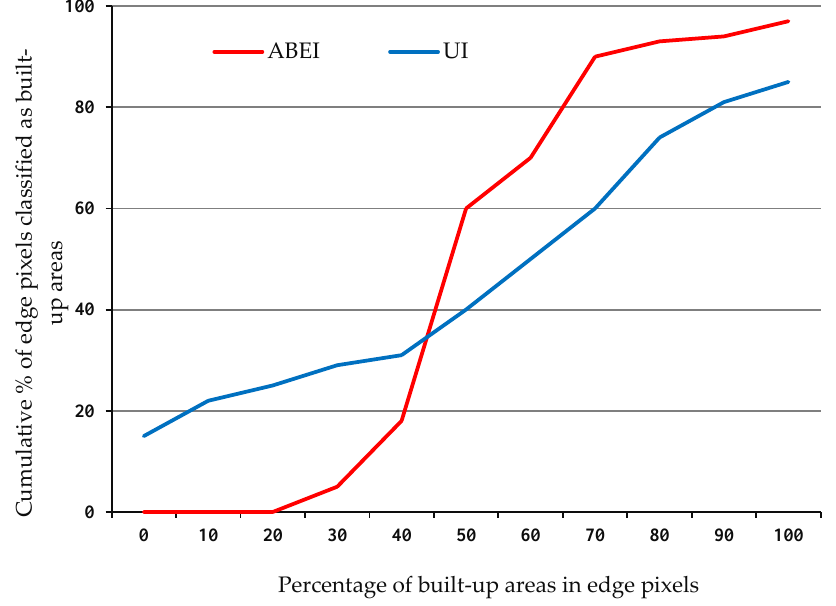
Figure 4. Cumulative frequency of mixed edge pixels classified as built-up pixels.